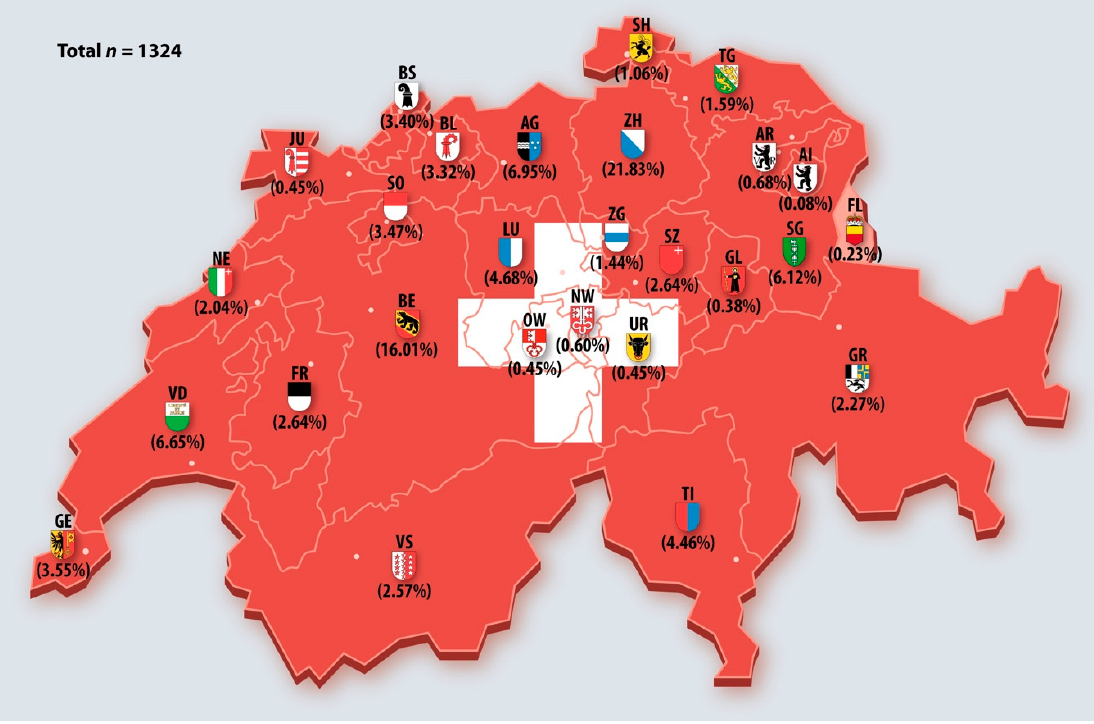
Figure 1. Map of Switzerland and the Principality of Liechtenstein with the percentage of participating dentists in the current study ( n = 1324).